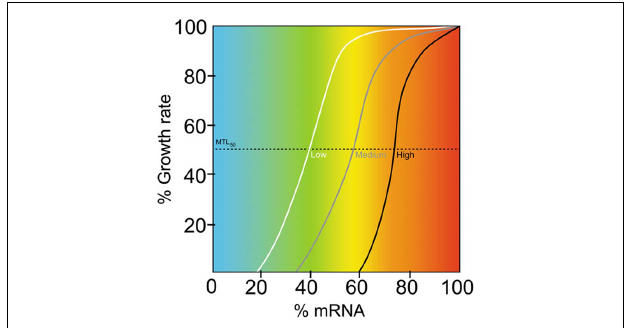
FIGURE 3 | Measuring the degree of gene essentiality. The relationship between the reduction of growth rate and the reduction in mRNA (antisense-induced gene silencing) is a measure of the degree of essentiality, or stringency, of an essential gene (Goh et al., 2009).The minimum transcript level for a 50% reduction in growth (MTL 50 , dotted line) can be used to compare genes. In this hypothetical example three genes are compared and show low (white line), medium (gray), and high (black) stringencies of requirement.